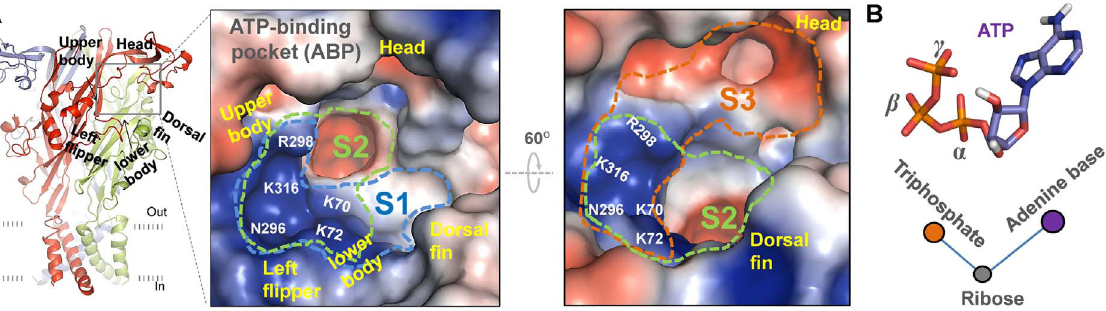
Figure 1. Stereo view of three-dimensional (3-D) structures of zf P2 X 4 and ATP-binding pocket (ABP). ( A ) 3-D architecture of zfP2 X 4 and ATP-binding pocket (ABP). The structure model constructed on the basis of the X-ray crystal closed structure of zfP2 X 4 (PDB entry code: 3H9V) is shown parallel to the membrane layer. Subunits A, B and C are displayed in red, green and blue cartoon, respectively. This figure and following Figures 2–6 are made with PyMol (http://www.pymol.org). 3-D architecture of ABP was highlighted within enlarged square box. S1, 2 and 3 indicate three potential sites that are able to contact with adenine ring of ATP. ( B ) The bent conformation of ATP.